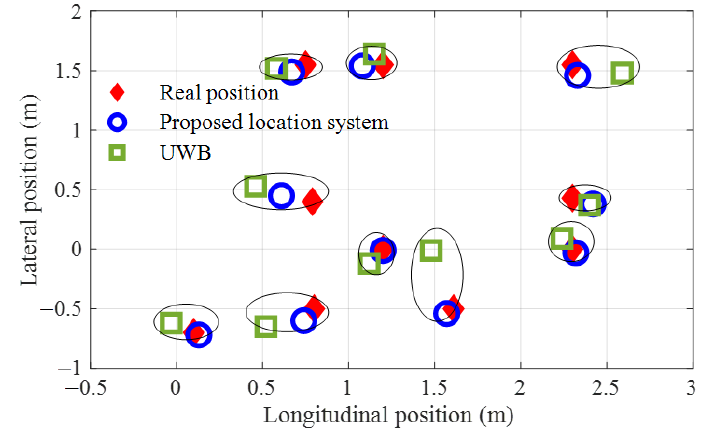
Figure 12. Comparative test results under statistical conditions.